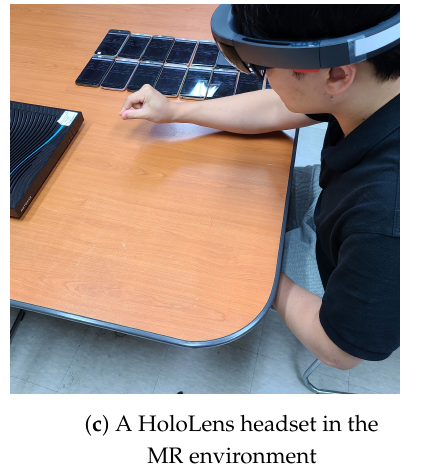
Figure 9. Mobile distributed ray tracingin AR and MR environments. Using the proposed mobile rendering system, it is possible to display ray-traced images at interactive frame rates on the displays of the tested AR and MR devices. By creating the optically-correct rendering effects such as shadow, reflection and refraction on these AR and MR devices, we can enhance the real scene images either captured by the AR device or perceived by the MR device, effectively augmenting the reality with 3D